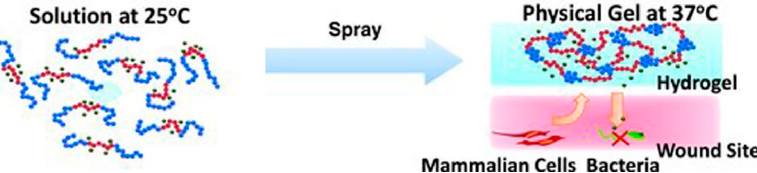
Figure 2. Schematic presentation of spray application of poly(12) as an antibacterial wound dressing hydrogel. Reprinted with permission from Reference [58], Copyright 2011, Wiley-VCH.